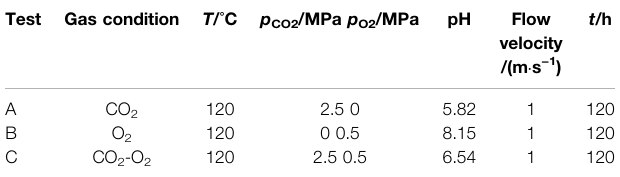
TABLE 2 | Experimental parameters of high temperature and high pressure under three gas conditions.